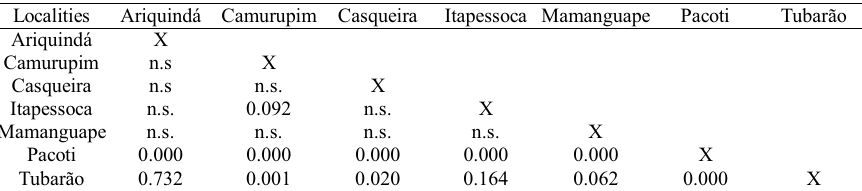
Table 5. Social associations and records of reproductive behavior in Hippocampus reidi at 12 Brazilian localities (means reported with confidence interval and range). ?=ongoing research (state of Piauí) or no data collected (elsewhere). Locality (Brazilian